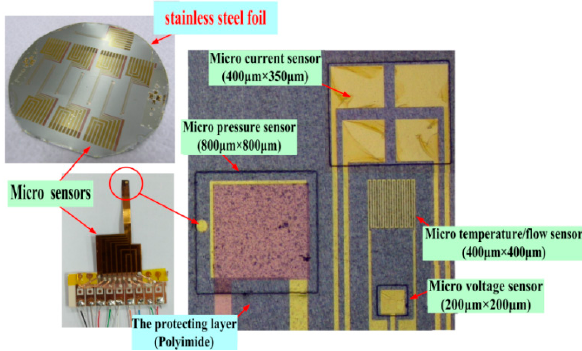
Figure 6. Real product and optical micrograph of five-in-one micro-sensor.